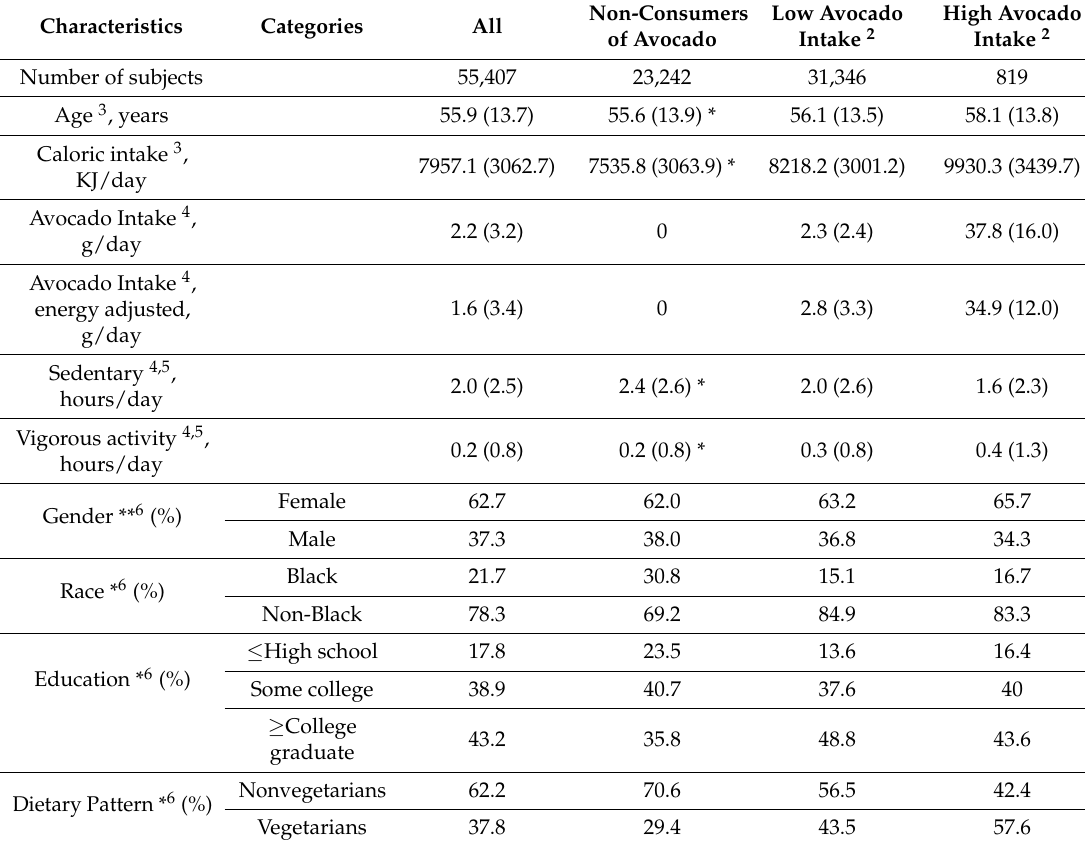
Table 1. Baseline characteristics of Adventist Health Study-2 subjects along with differences by level of avocado intake 1 .